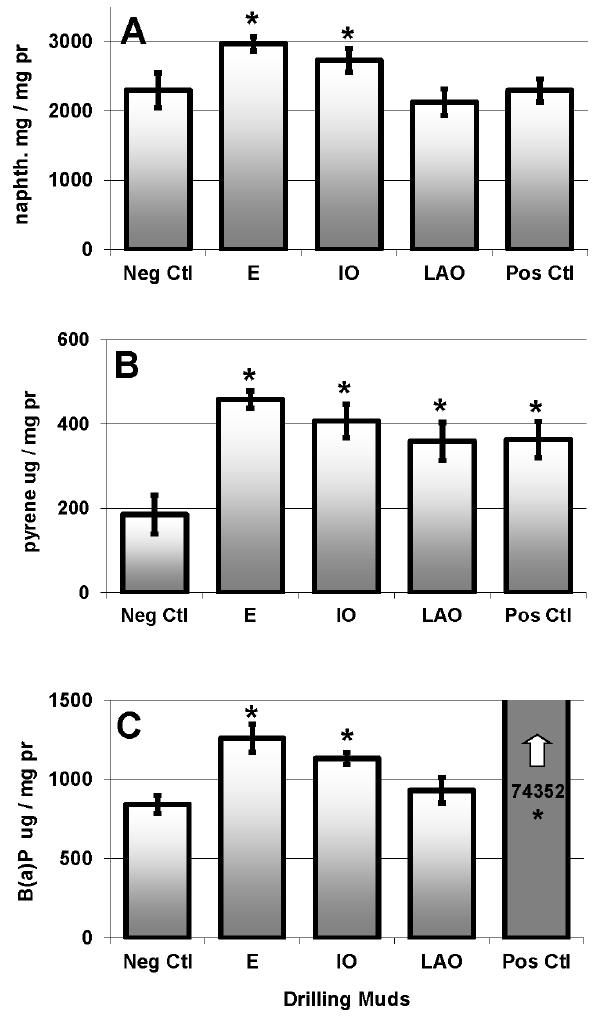
Figure 2. Biliary fluorescence (mean 6 SEM ) at A: naphthalene wavelength, B: pyrene wavelength, C: B(a)P wavelength. E: ester; IO: isomerised olefin; LAO: linear alpha olefin SBMs. * indicates statistically different from negative control fish.